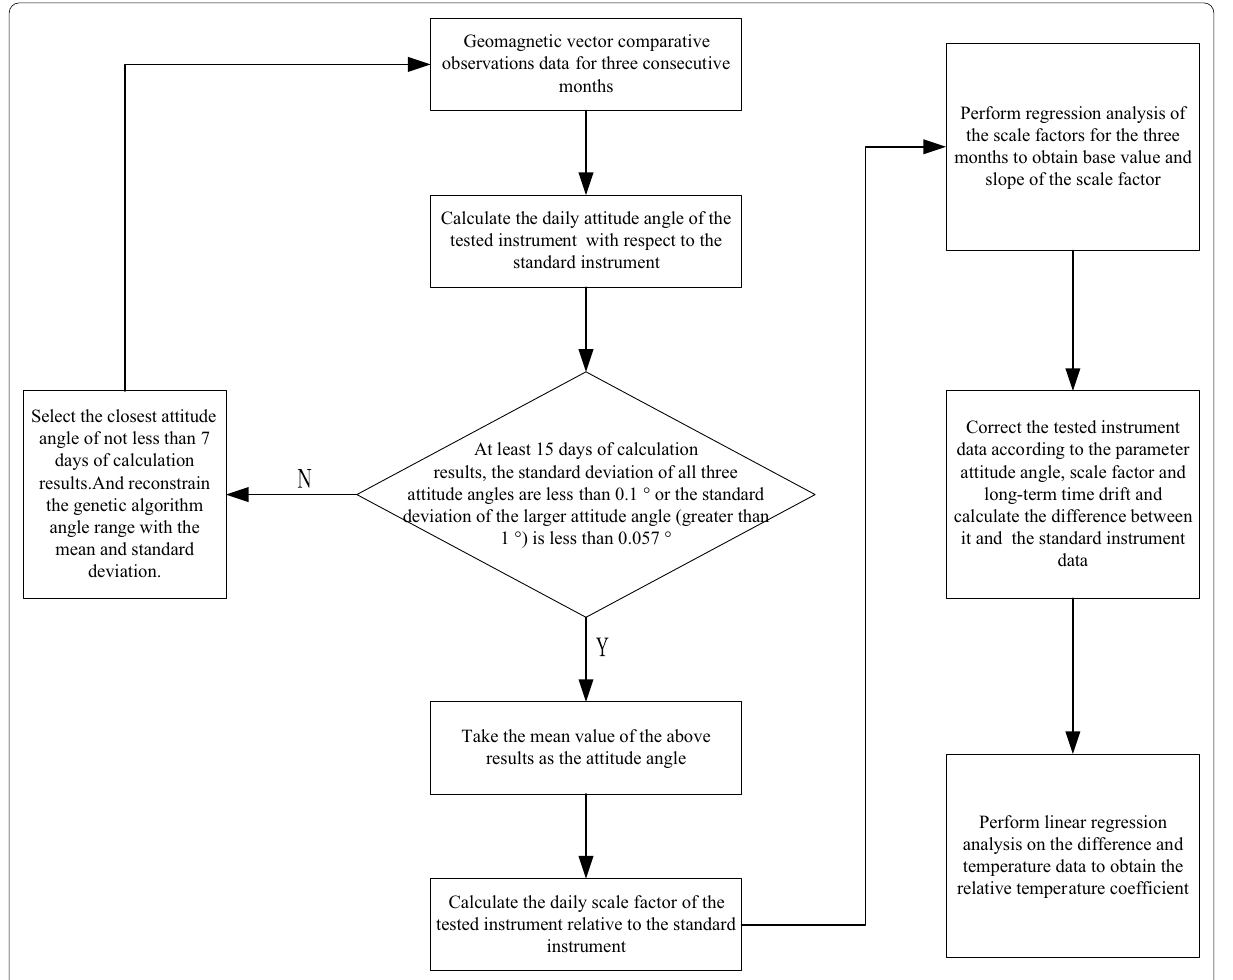
Fig. 3 Calculation flow chart for the long-term correction